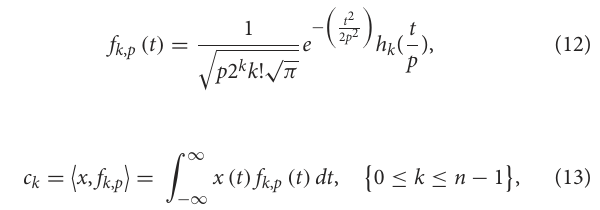
Algorithm 8. Hilbert-Huang transform (Azlan and Low,